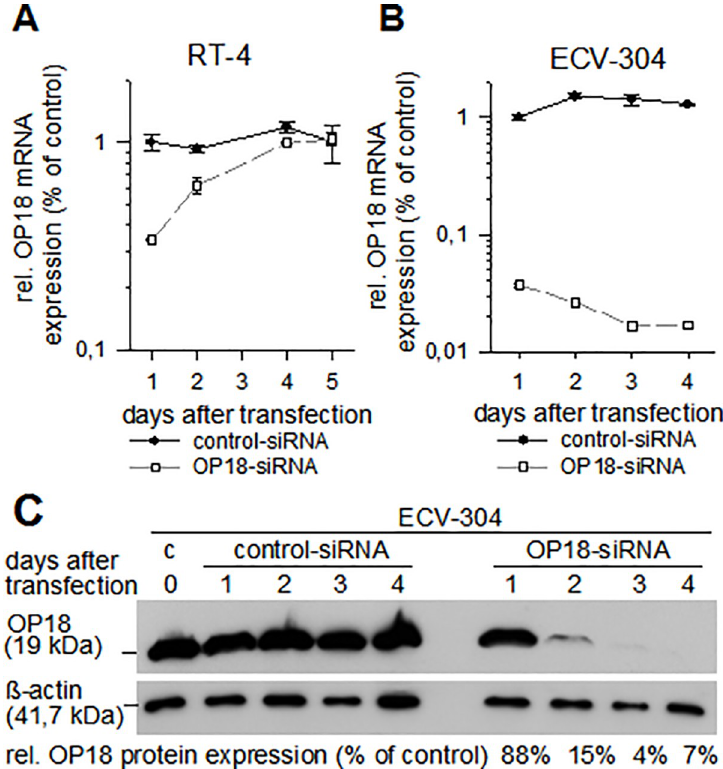
Fig 2. Validation of siRNAs. The two cell lines RT-4 (A) and ECV-304 (B) were transfected with OP18-directed siRNA or control siRNA at 30 nM. Total RNA was prepared after transfection at the indicated time points and levels of OP18- and RPLP0-mRNA were detected by qRT-PCR in triplicate. Symbols represent mean relative OP18 mRNA expression ± standard deviation as normalized to RPLP0. While RT-4 cells show transient and weak suppression of OP18 expression at days 1 and 2, ECV-304 cells show a substantial reduction of OP18 mRNA levels over a time period of 4 days which is statistically significant (see Materials & Methods). (C), relative OP18 protein amount in siRNA- treated ECV-304 cells. Cells were transfected with control-siRNA or OP18-siRNA (each at 30 nM). At 0, 1, 2, 3, and 4 days after transfection, cells were lysed, and OP18 protein and beta-actin were detected using western blotting. Signals of OP18 were normalized to beta-actin. Percentages of OP18 protein suppression in comparison to control cells is indicated in the lower panel of the blot.